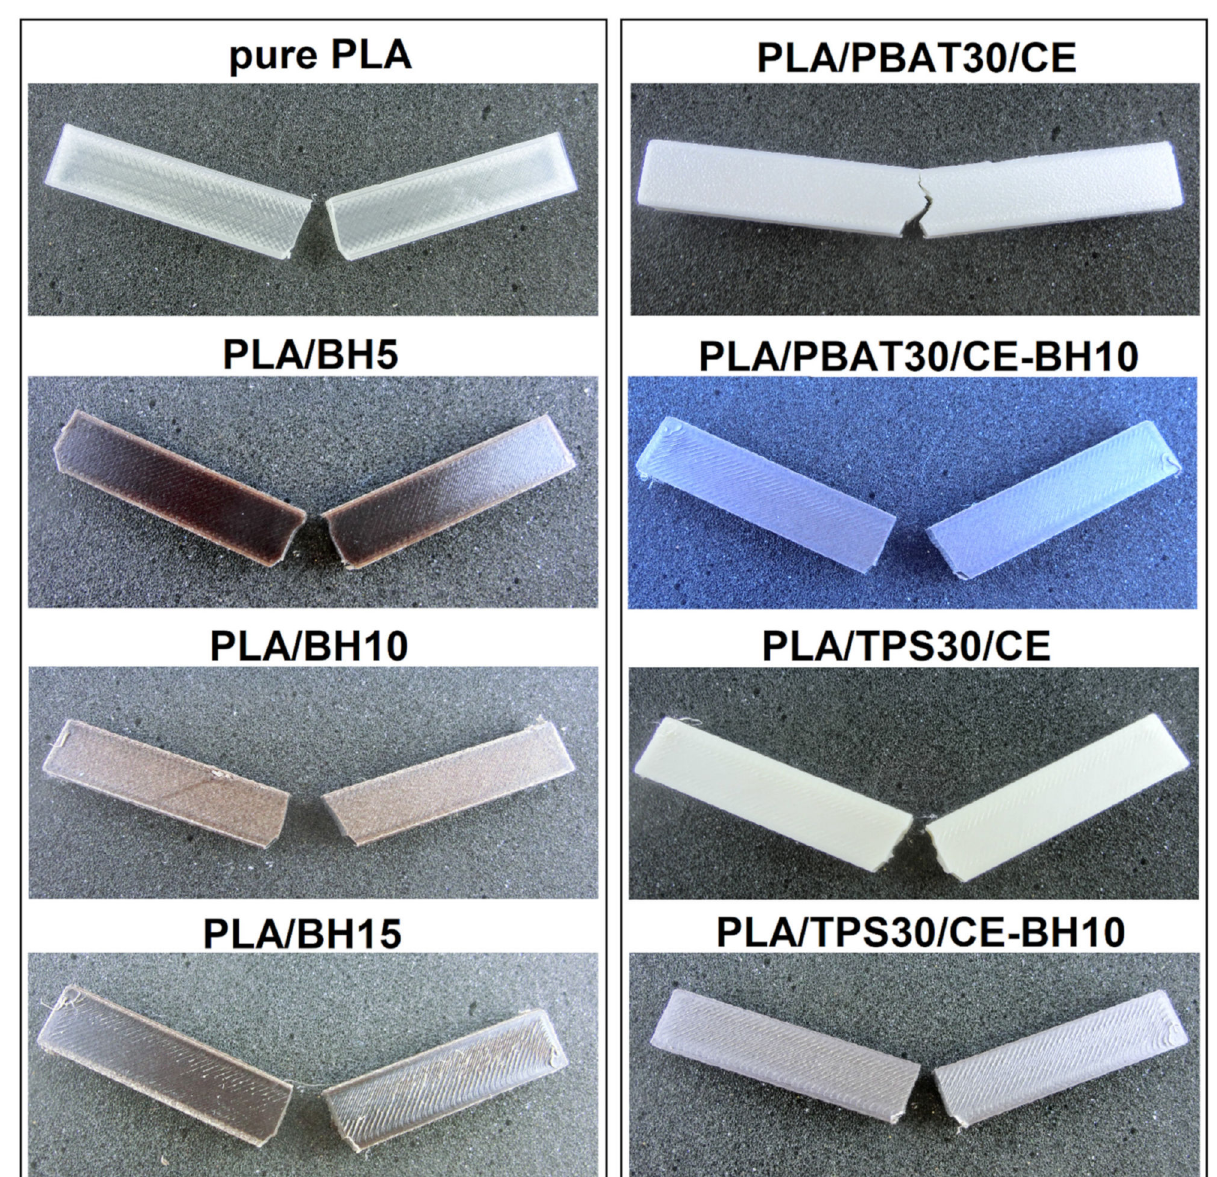
Figure 14. The macroscopic appearance of the 3D printed samples, pictures present the impact test specimens after the